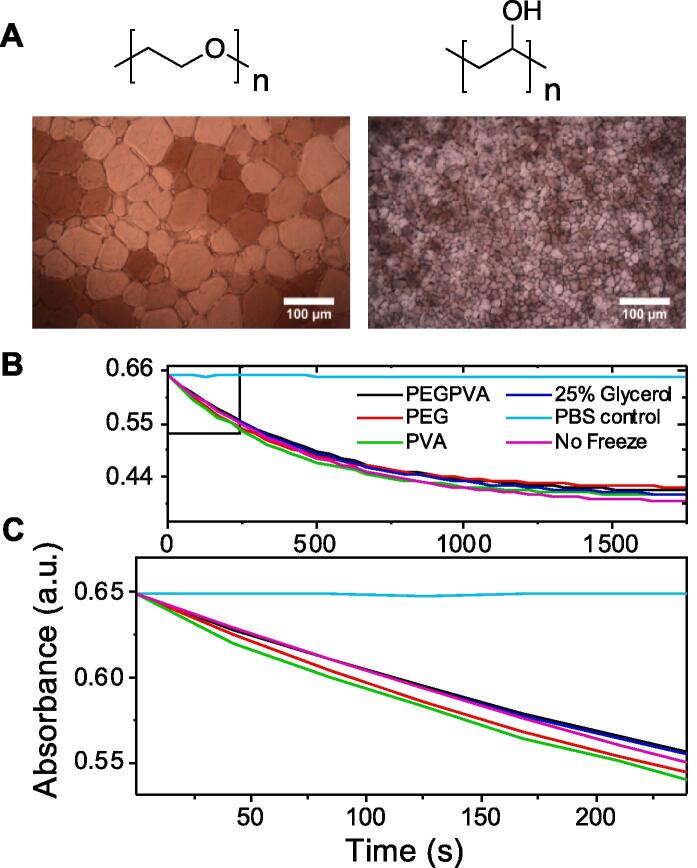
A) Chemical structure of PEG/PVA and representative ice wafers grown with each polymer [PEG] = 10 mg.mL−1, [PVA] = 1 mg.mL−1; B) LDH activity recovery in the (PEG = 100 mg.mL−1, PVA = 1 mg.mL−1) after 5 FT cycles (−196 to 25 °C), recorded by catalysis of NADH to NAD+, observed by a decrease in absorbance, compared to a no CPA control (buffer); C) Zoom in of linear region.